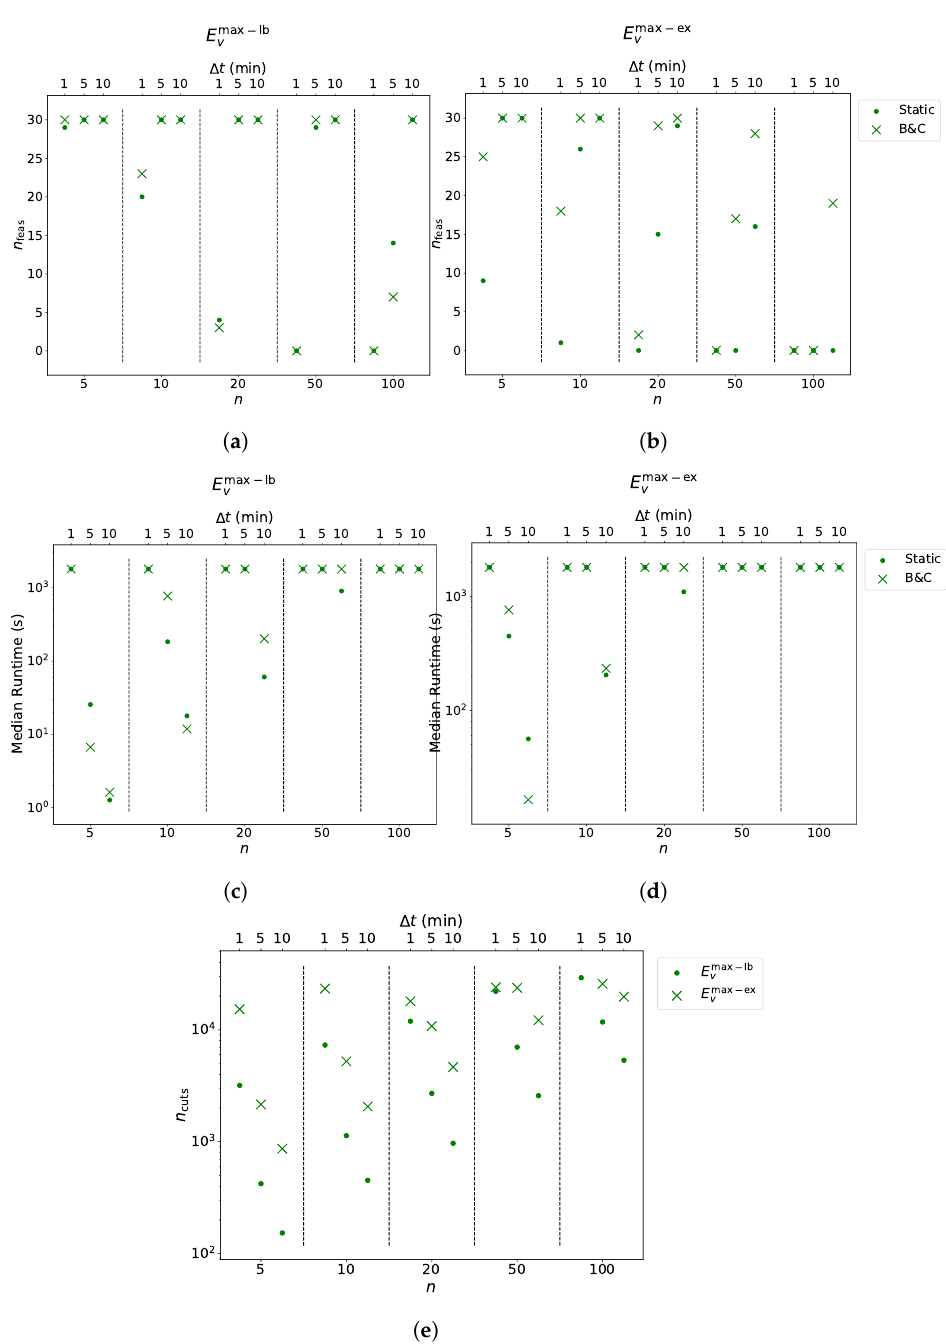
Figure 8. Visualization of EVS-SOC-GLIN results for solving the static model versus B&C with E max-lb v and E max-ex v based on five-segment piecewise linear approximations of the original P max v functions, P gridmax = 25 n . ( a ) Number of feasible solutions found for E max-lb v . ( b ) Number of feasible solutions found for E max-ex v . ( c ) Median runtimes for E max-lb v . ( d ) Median runtimes for E max-ex v . ( e ) Median number of cuts added within B&C for E max-lb v as well as E max-ex v